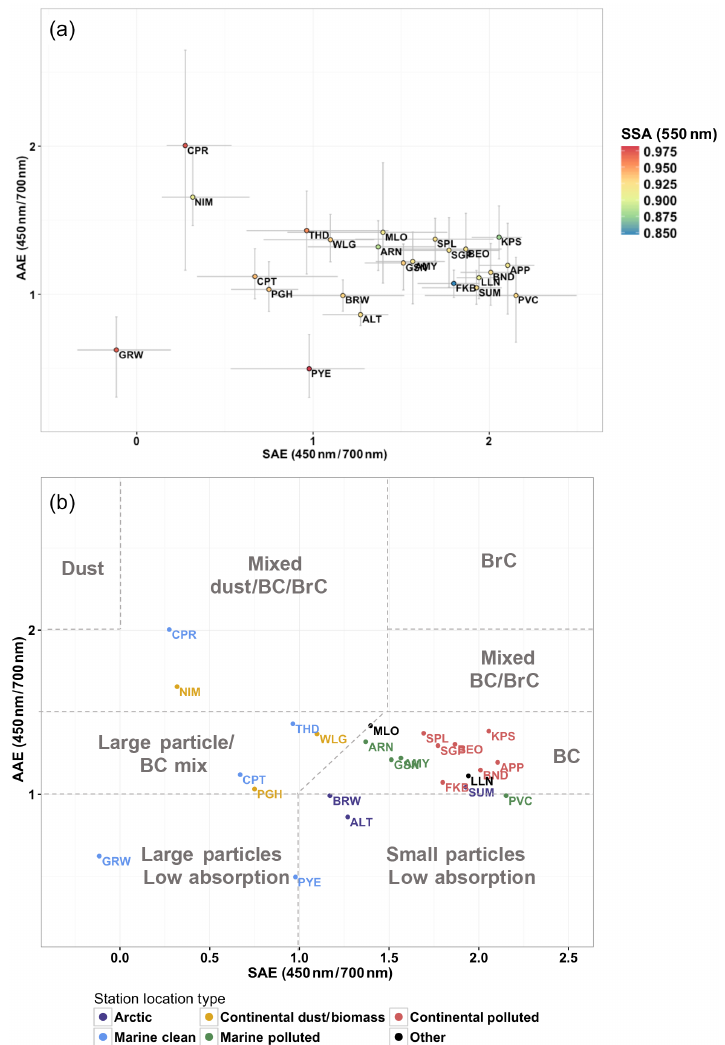
Figure 2. AAE vs. SAE medians plotted for 24 in situ monitoring stations in the NOAA/ESRL Federated Aerosol Monitoring Network. (a) Bars represent interquartile values, and points are color-coded by median SSA value at the station; (b) points are color-coded by station location type, and the plot is overlaid with the aerosol classification matrix from Cappa et al.